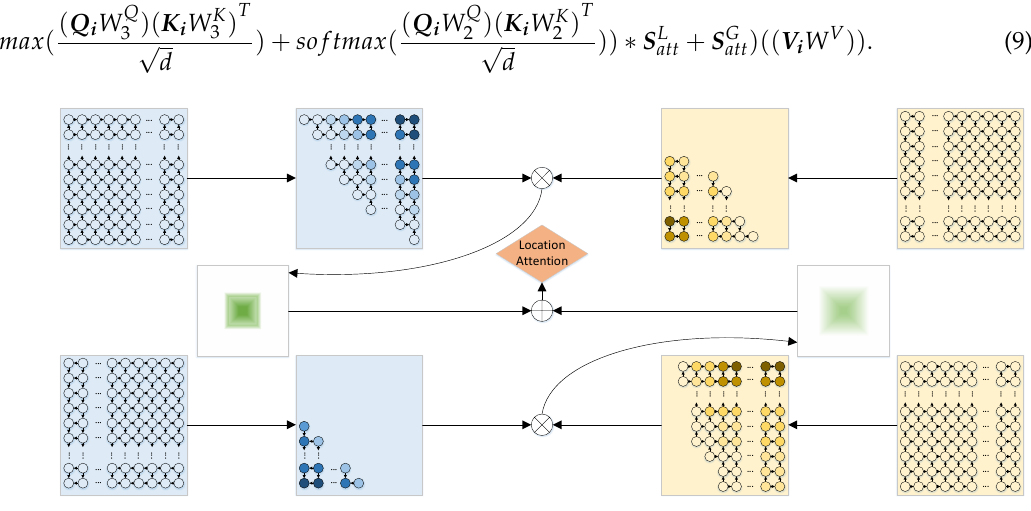
Figure 3. Illustration of Location Attention Cumulation (LAC), which exposes the concrete working process by spreading attention scores along a fixed